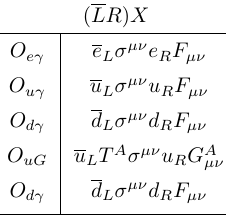
Table 10 . LEFT dipole (dimension five) operators.